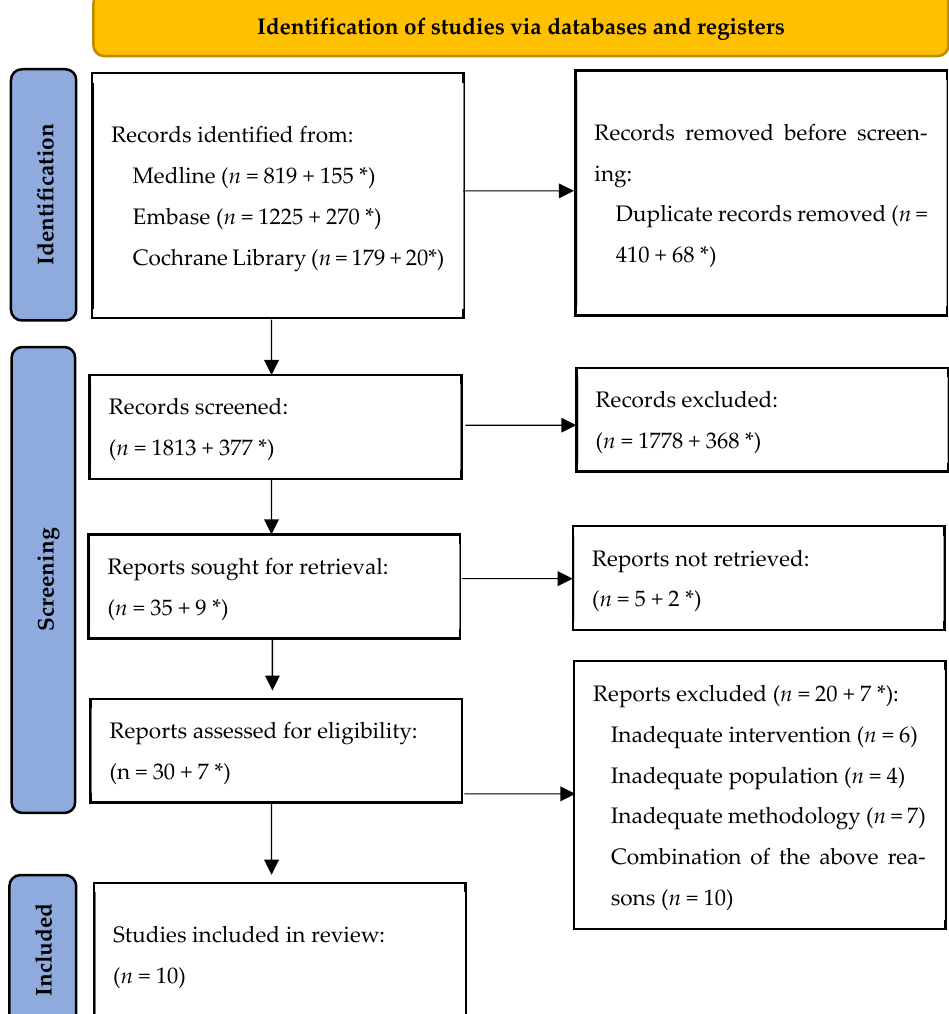
Figure 1. PRISMA flow diagram. * studies found as a result of a search update conducted for the period from 14 March 2021 to 24 May 2022.